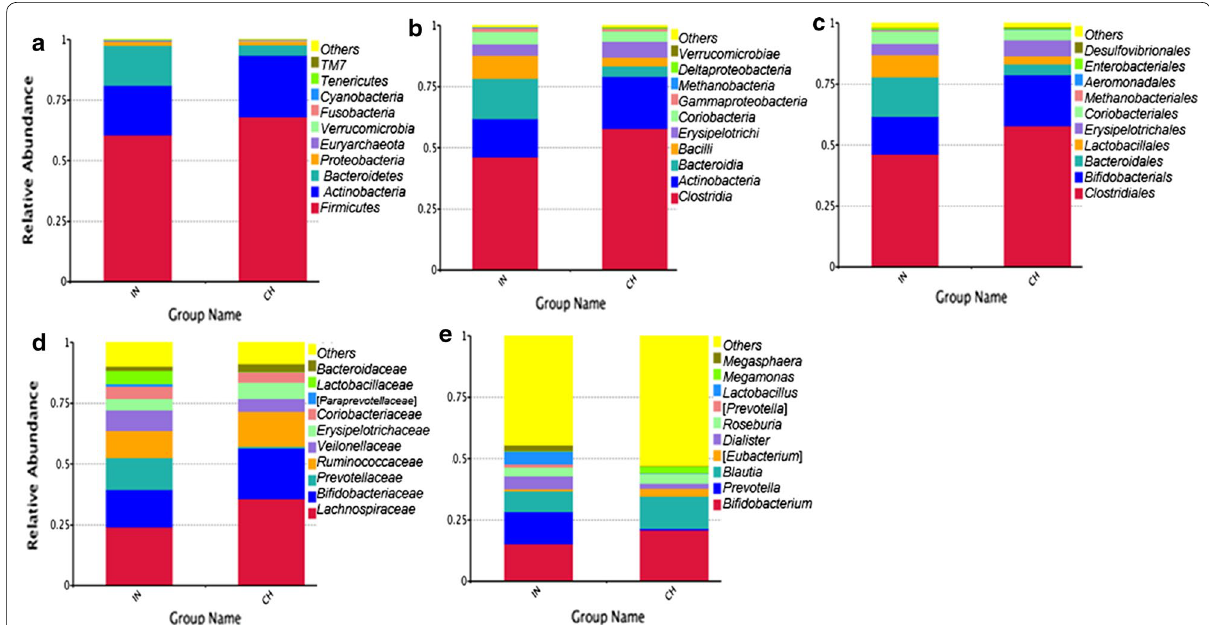
Additional file 6: Figure S2. Overall, the gut bacterial profiles of Indians and Chinese had the similar value